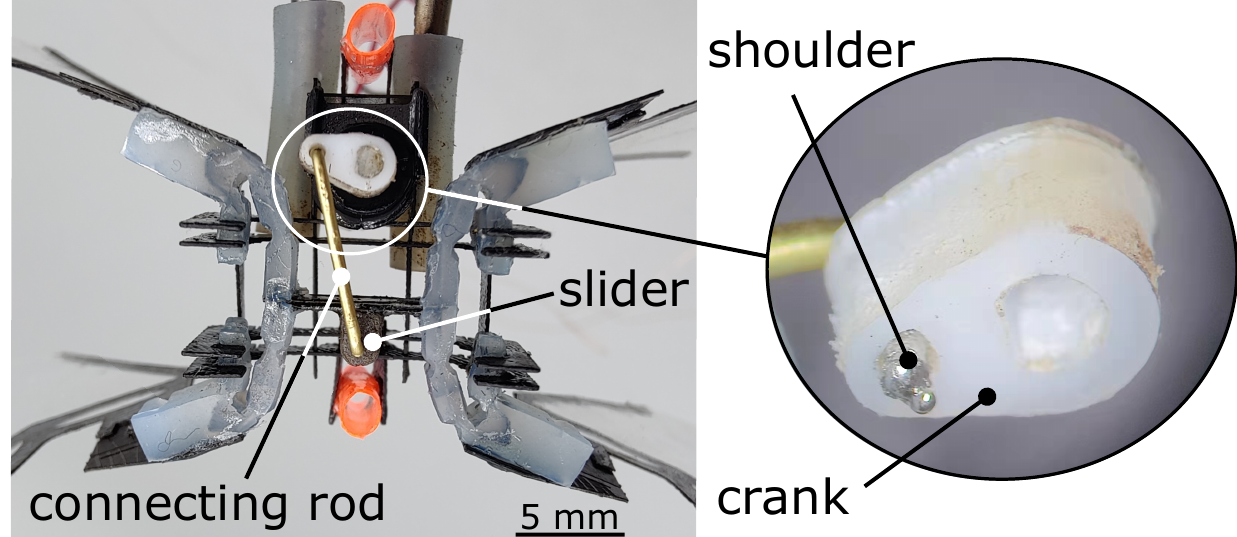
Figure 8. Close-up view of the slider crank; the soldering tip on the connecting rod serves as a rod shoulder to limit the crank